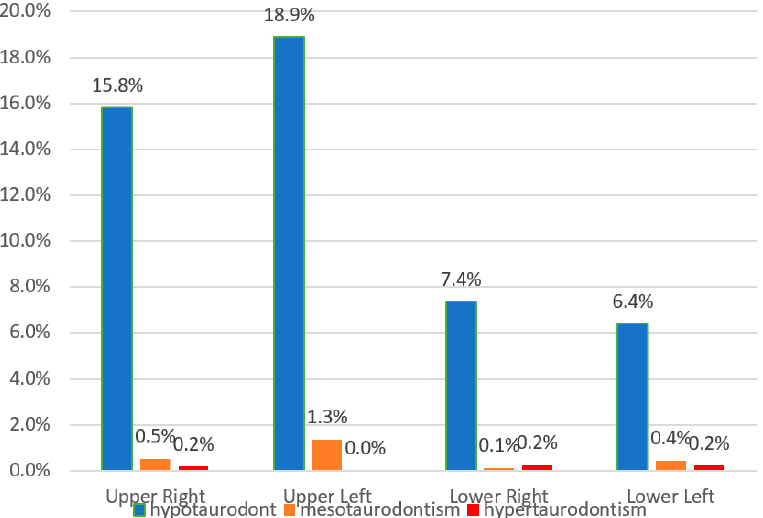
Figure 3. The distribution of hypotaurodont, mesotaurodont, and hypertaurodont teeth in the four quadrants of the mouth.